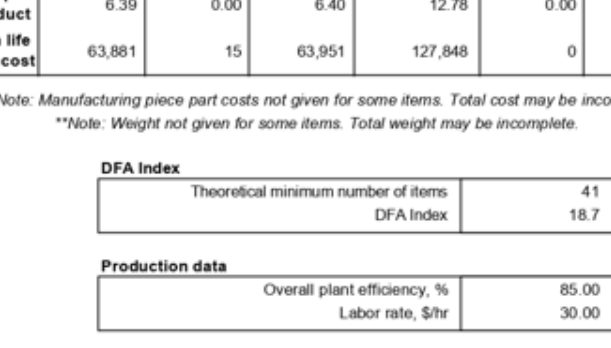
Figure 9. DFA analysis total for product redesign.